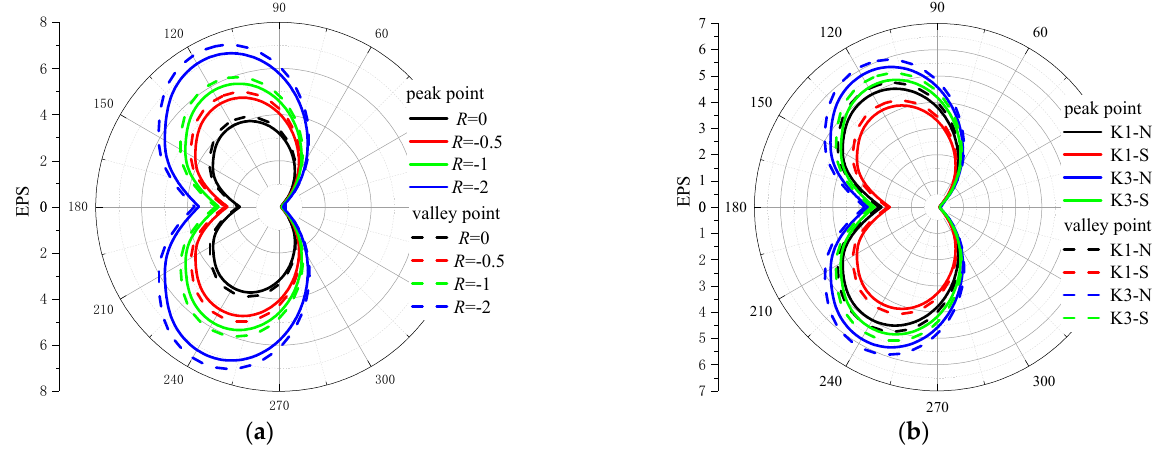
Figure 8. Circumferential distribution of EPS: ( a ) effect of loading ratio R , ( b ) effect of specimen type.